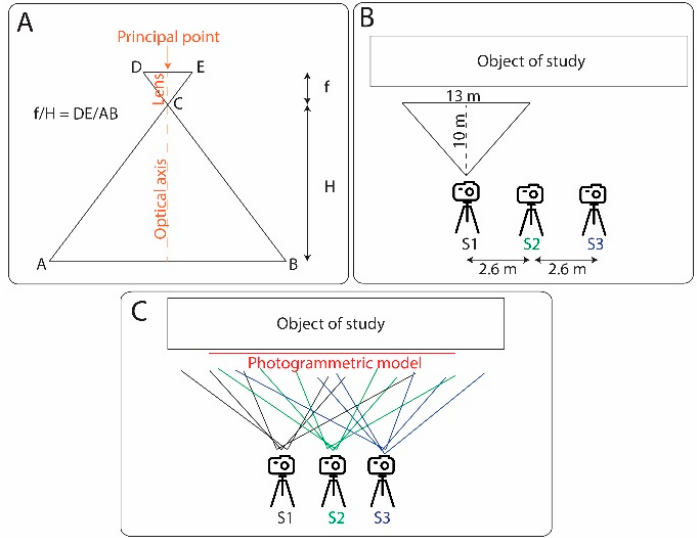
Figure 4. ( A ) Schematic representation of the geometric characteristics of the photographs and associated formula. ( B ) Schematic representation of the DP station and the area of coverage. ( C ) Image fan method.